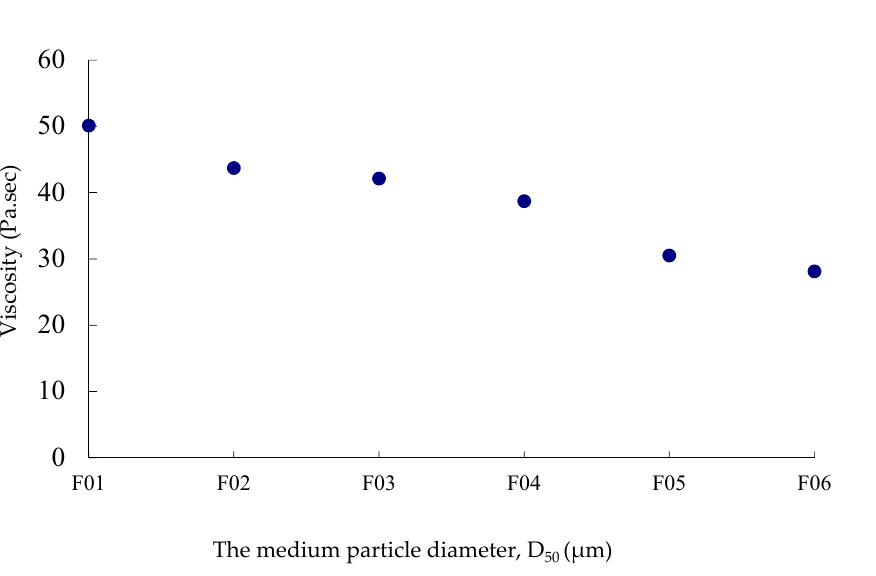
Figure 1. Flow spiral length versus D50 for EMCs with polygonal fused silica fillers ( σ : 0.632 cm–1.356 cm).